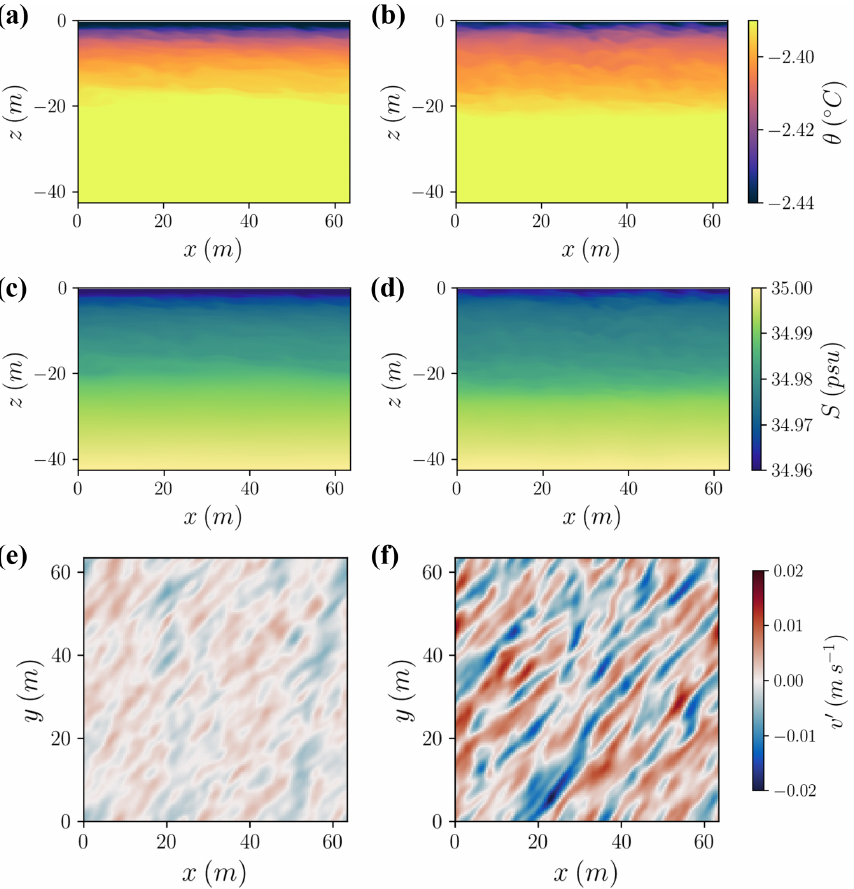
Figure 6. Instantaneous flow structures observed at 40h in the (a, c, e) 0.01 ◦ slope case and (b, d, f) 1 ◦ slope case. (a, b) Temperature in cross section mid-way through the y axis. (c, d) Salinity in cross section mid-way through the y axis. (e, f) Resolved cross-slope velocity fluctuations at 1m below the ice–ocean interface.